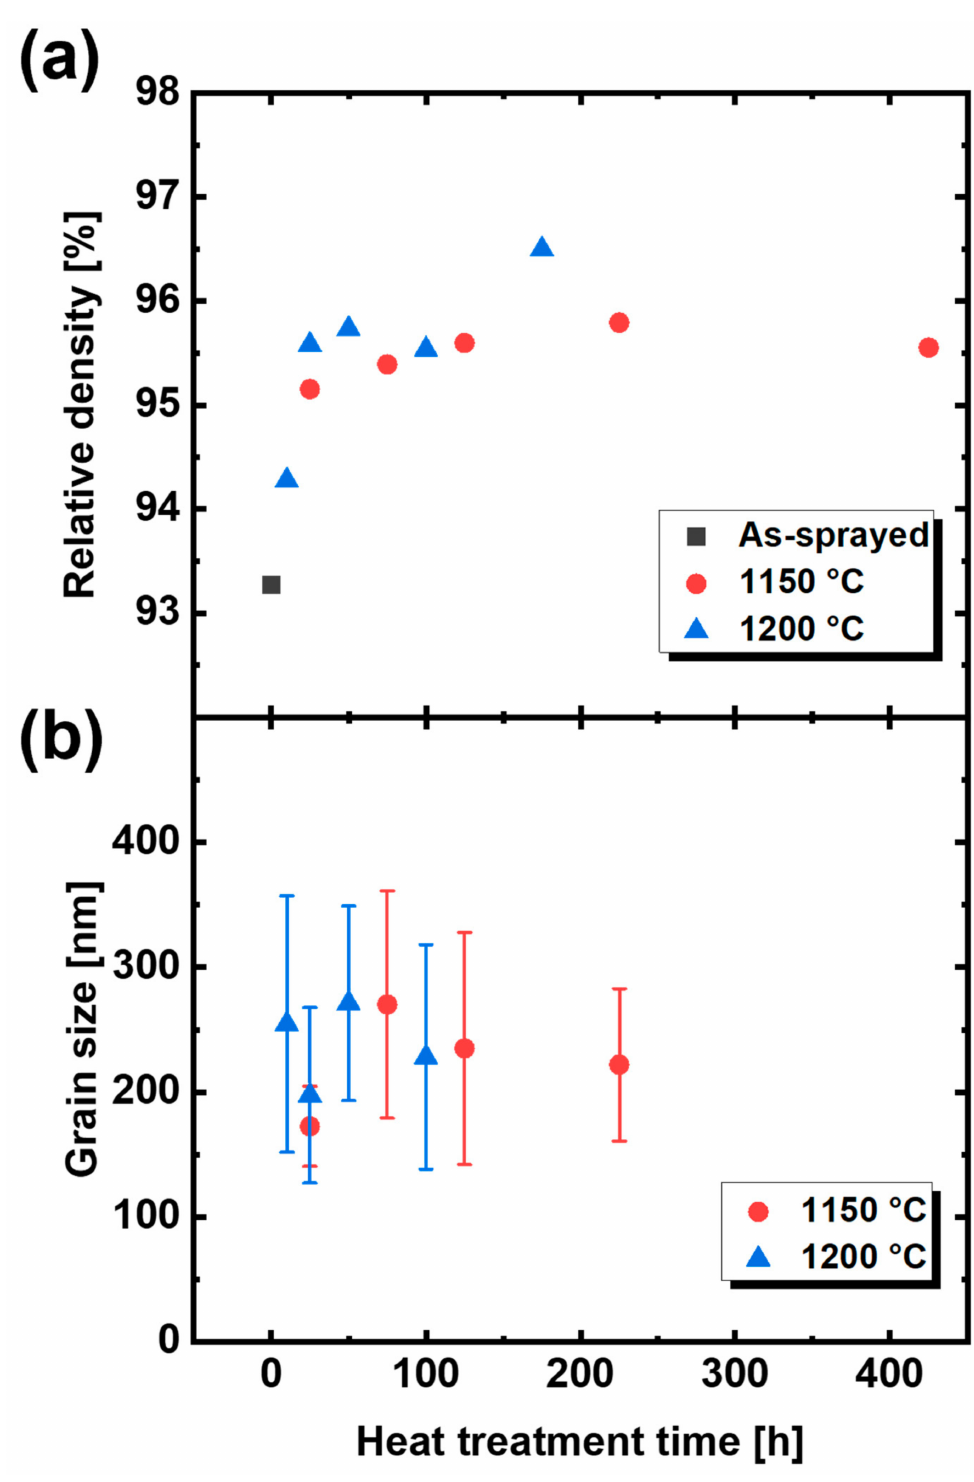
Figure 5. ( a ) Relative density and ( b ) grain size after thermal aging as a function of heat treatment